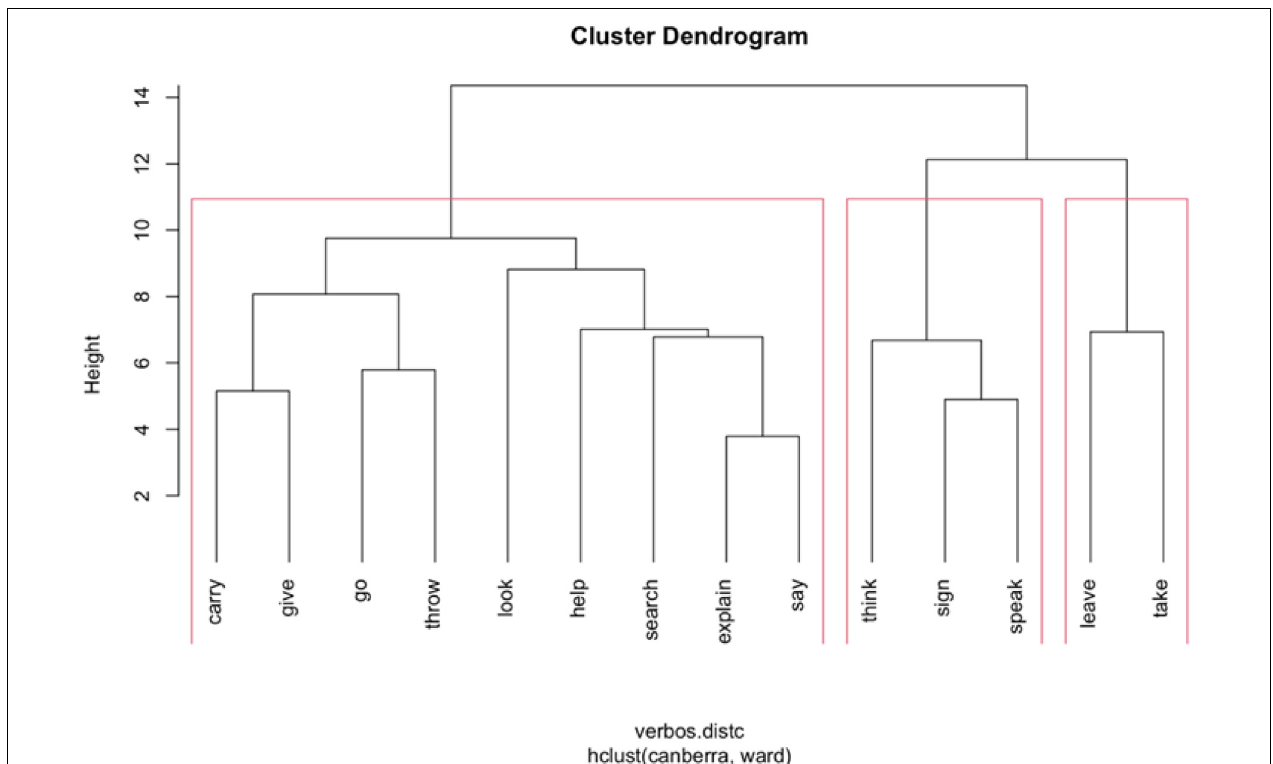
FIGURE 5 | Cluster dendrogram of verb